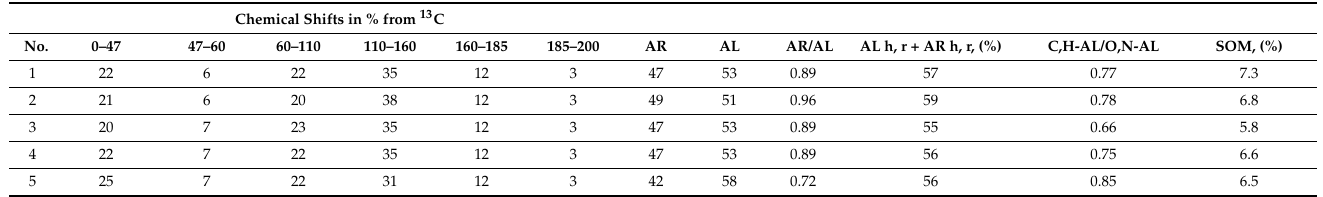
Table 6. Percentage of C in the main structural fragments of HAs from the studied surface soil horizons 1